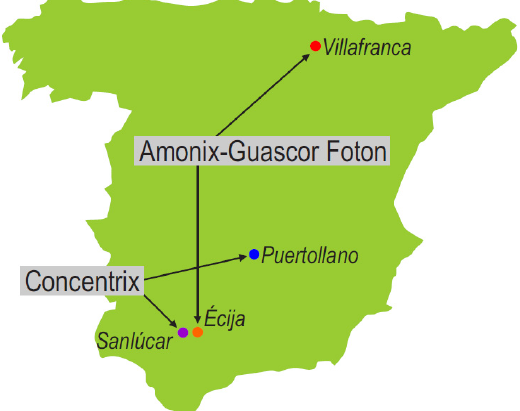
Figure 1. Locations of the analyzed